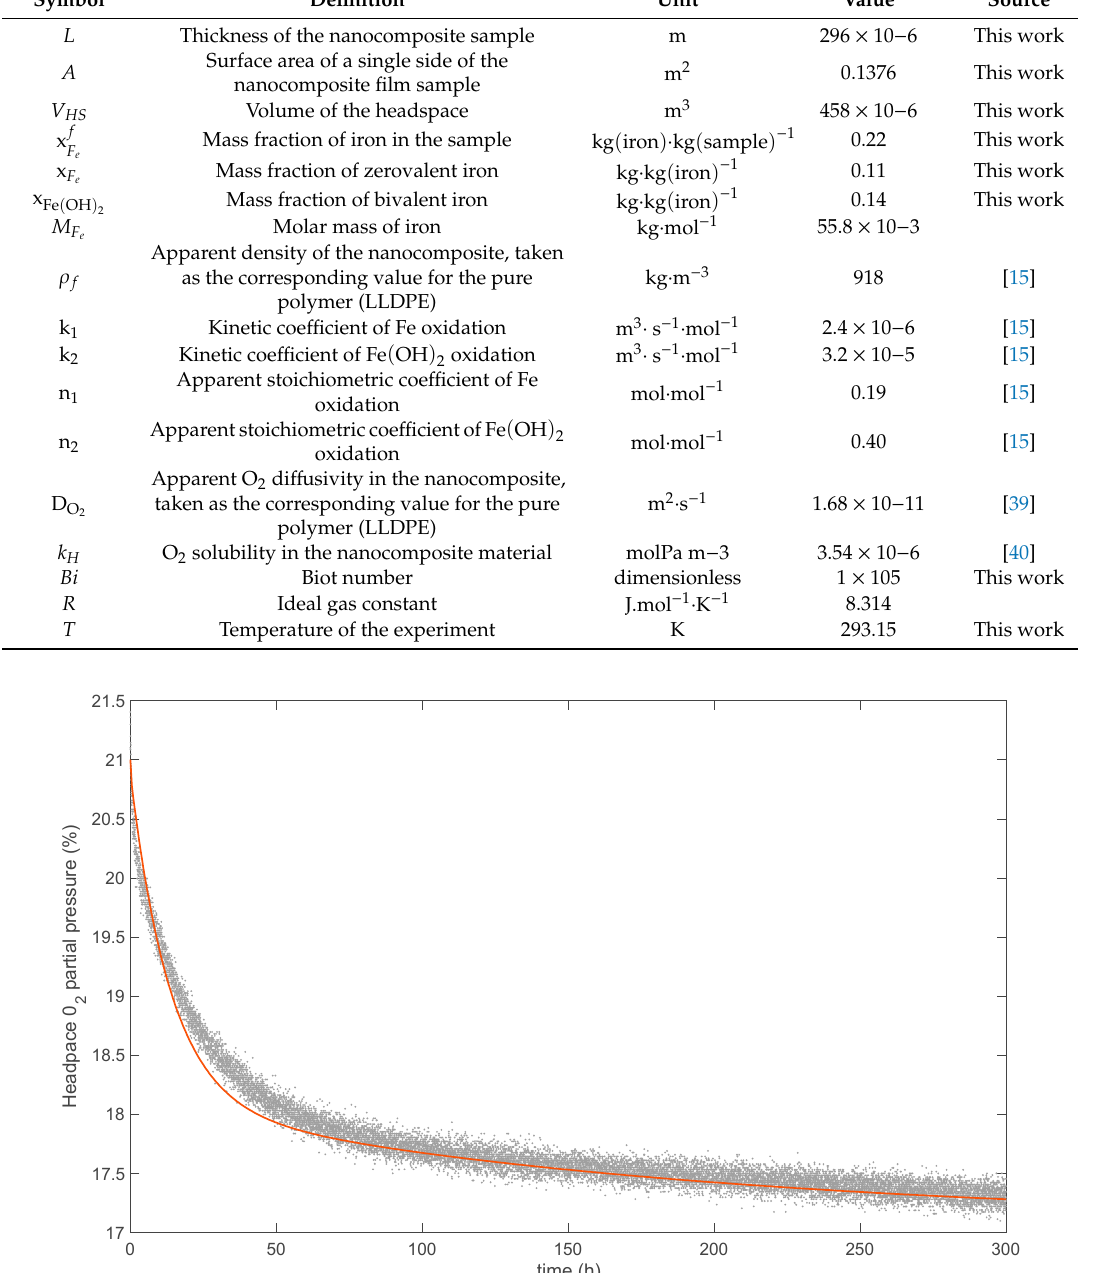
Figure 8. Comparison between simulated (red line) and experimental (grey dots) headspace–O 2 depletion curves.